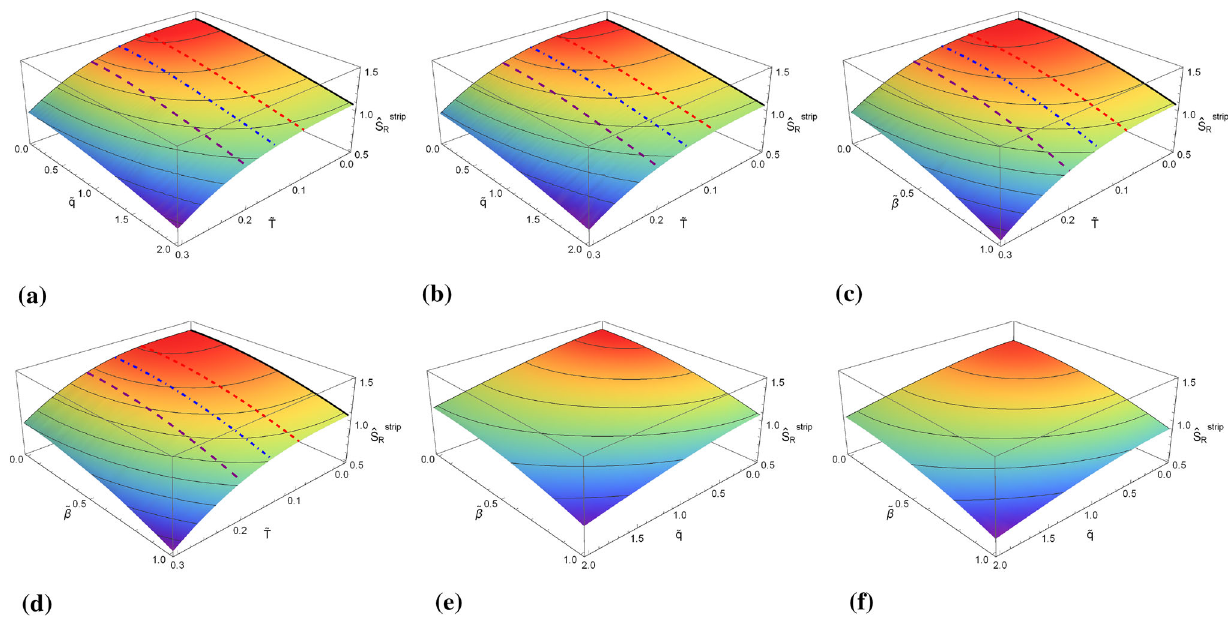
Fig. 2 The refined function ˆ S strip these lines are plotted in Fig. 3. This result is easily extended to the at a ˜ β = 0, b ˜ β = 0 . 2, c ˜ q = 0, R entanglement entropy in the presence of magnetic field. Thus one may d ˜ q = 0 . 2, e ˜ T = 0 and f ˜ T = 0 . 2 : the lines on the surfaces denote ˜ T (cid:11) = 0(Solid), 0.1(Shortdashed), 0.15(Dotdashed), 0.2(Longdashed) and regard ˜ q and